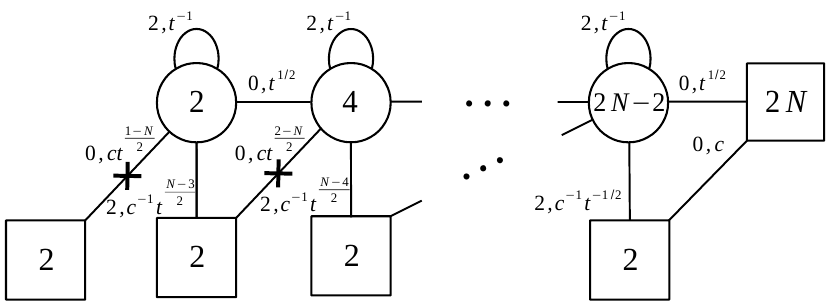
Figure 15 . Charges of the matter fields of E [USp(2 N )] under the abelian symmetries and the R